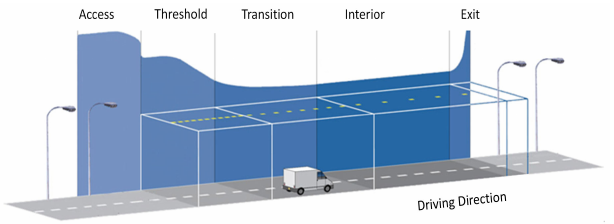
Figure 5. Tunnel zones for light